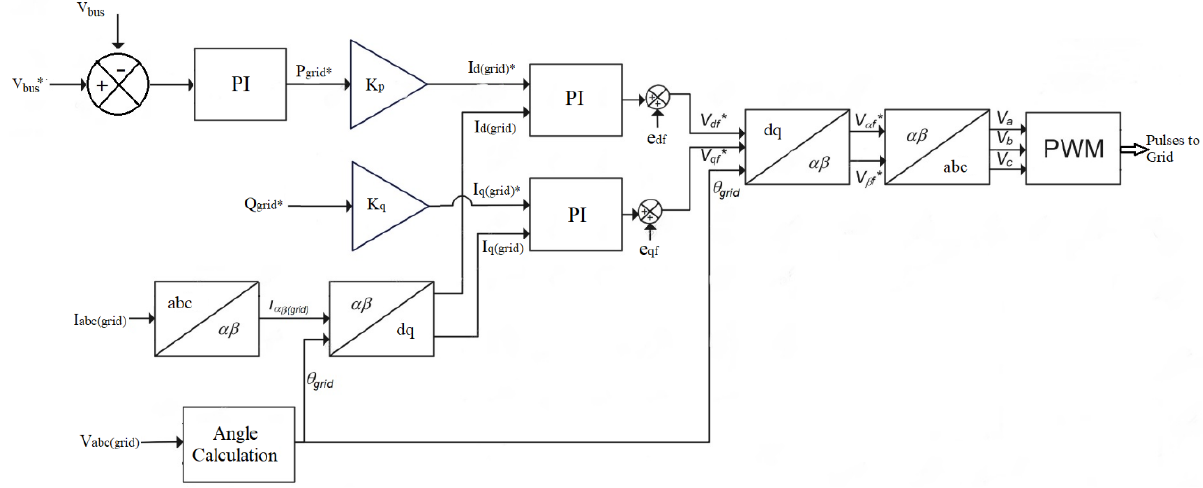
Figure 3. Schematic of the Grid Side Converter control. A vector-controlled, double closed loop structure, associated with the PI controllers, is used in GSC as it provides a satisfactory operation while regulating the DC